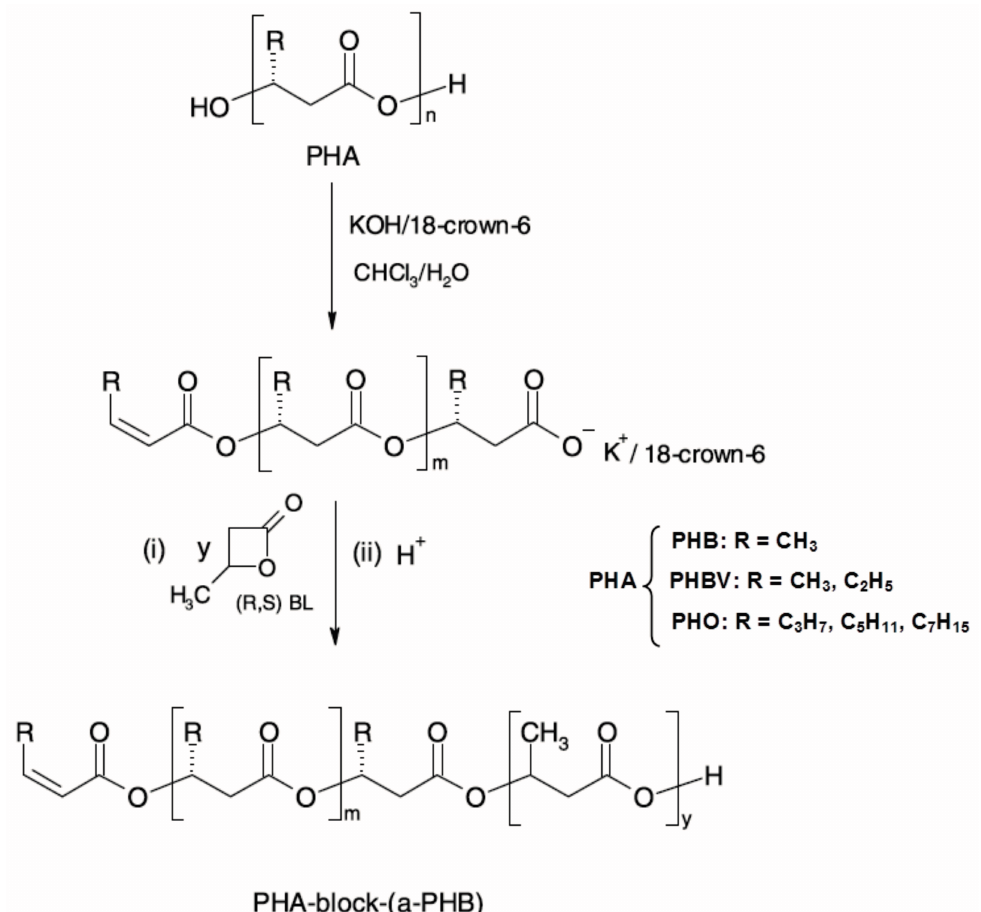
Figure 5. Preparation of block copolymers PHA- block -aPHB from low-molar mass macroinitiators, originally published in